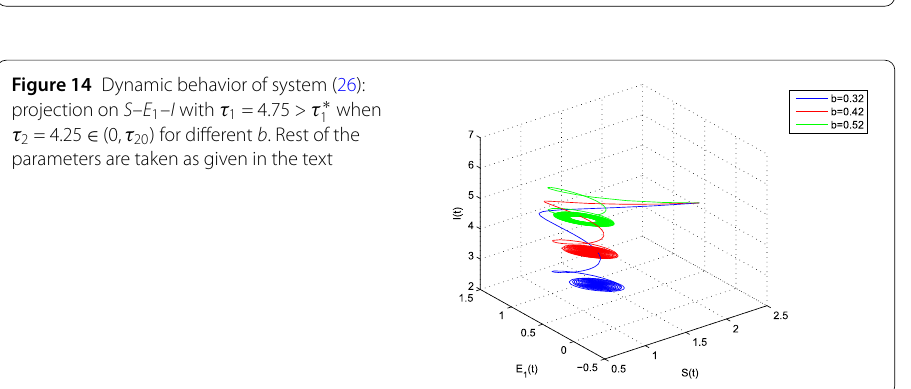
Figure 13 Time plots of S , E 1 , E 2 and I for different b at τ 1 = 4.05 when τ 2 = 4.25 ∈ (0, τ 20 ). Rest of the parameters are taken as given in the text